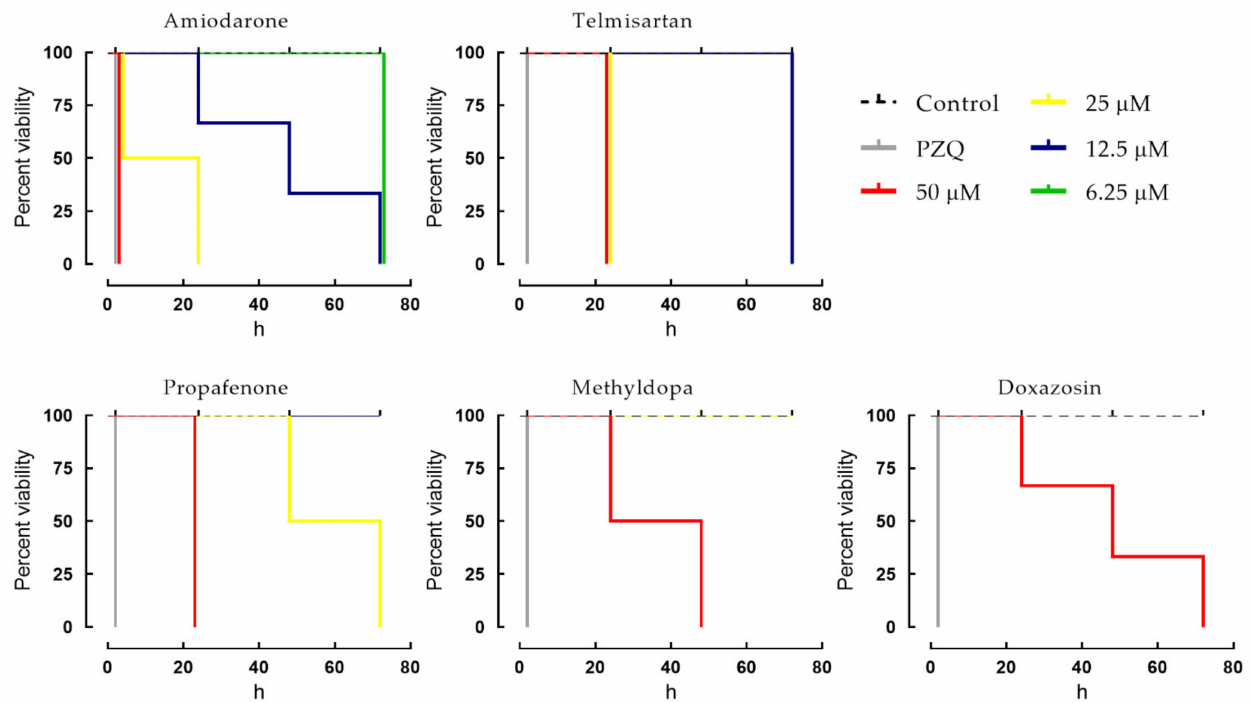
Figure 2. Viability of S. mansoni ex vivo following exposure to cardiovascular agents. Adult worms were obtained from mice by perfusion 49 days after infection. Parasites were monitored for up to 72 h and survival was plotted as a percentage over time using the Kaplan–Meier curves. Mean values were derived from a minimum of three experiments, and each experiment was performed with five replicates. Control (dashed line): RPMI 1640 + 0.5% DMSO. PZQ, praziquantel at 2 µ